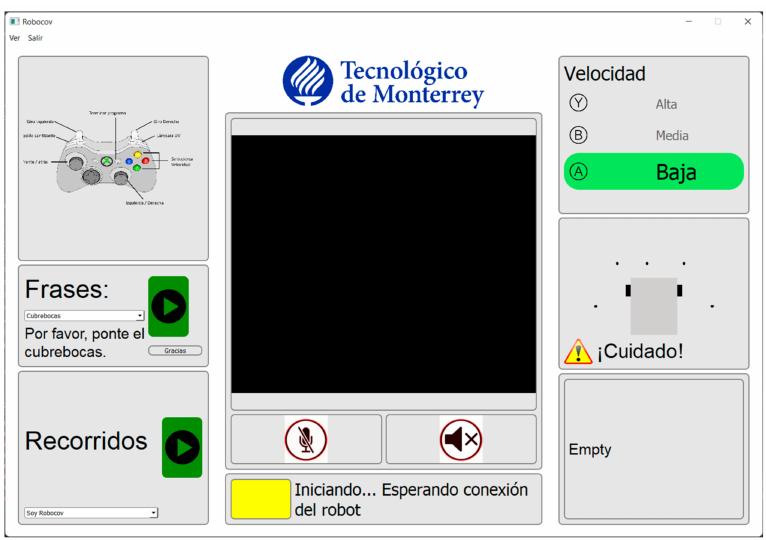
Figure 21. Robocov interface on the main